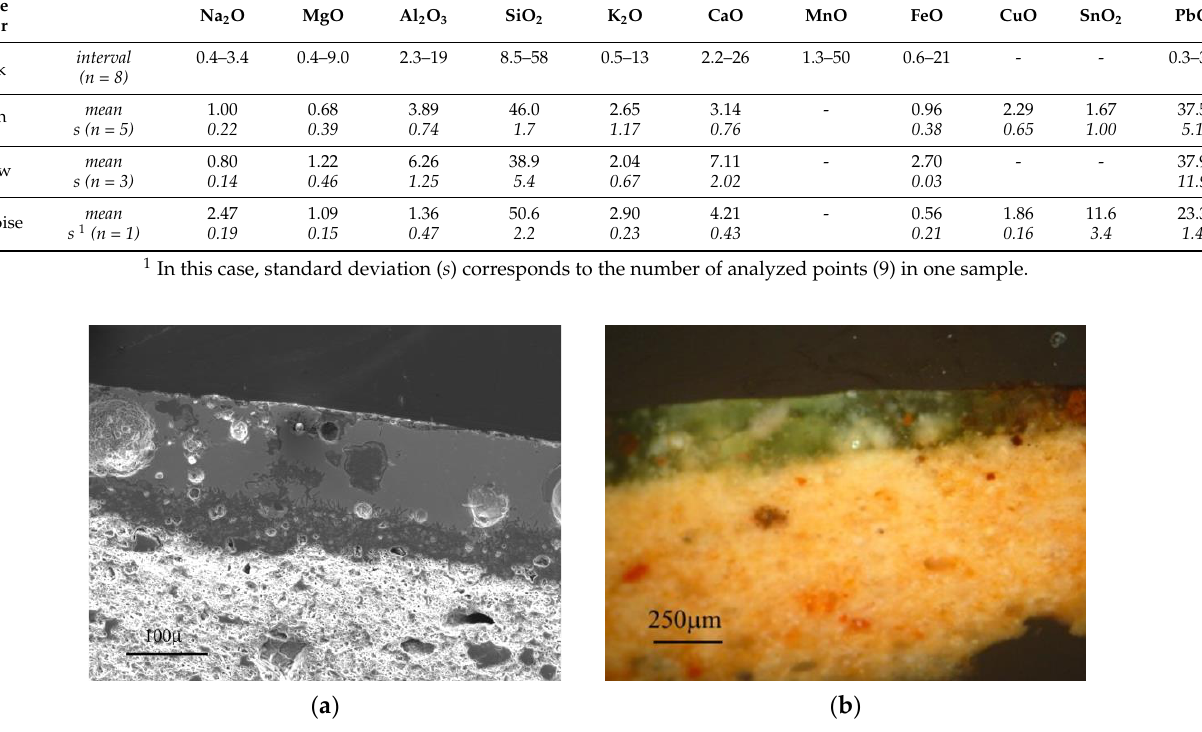
Figure 6. Cuerda-seca decorated glazes: ( a ) Secondary electron-SEM image of the glaze; ( b ) Optical Microscopy image of cuerda-seca decoration.